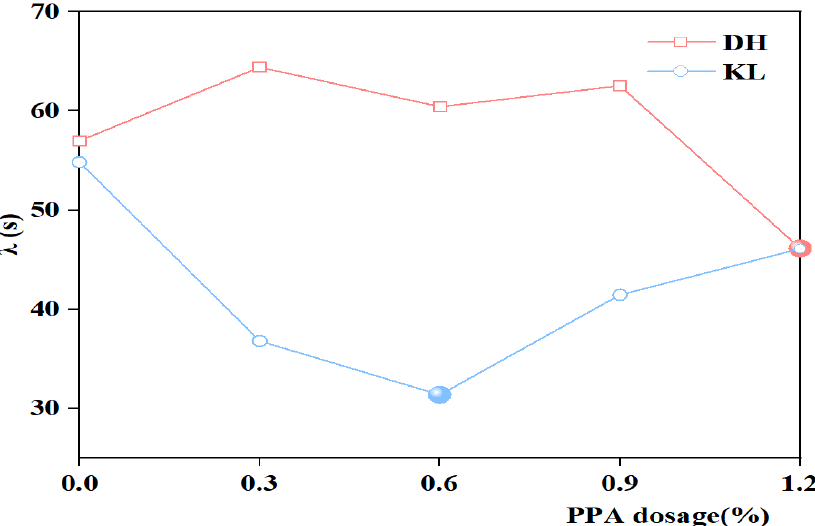
Figure 16. The λ value of single modified asphalt with different PPA dosages.